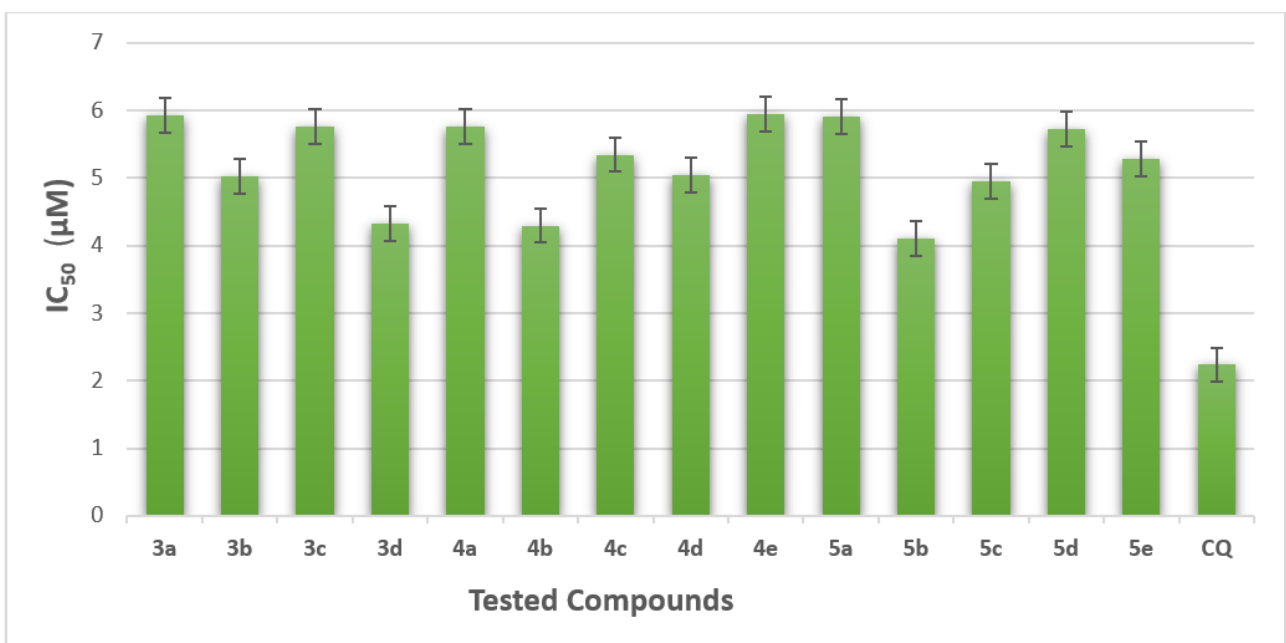
Figure 4. IC 50 of the newly synthesized compounds, and chloroquine at different concentrations.